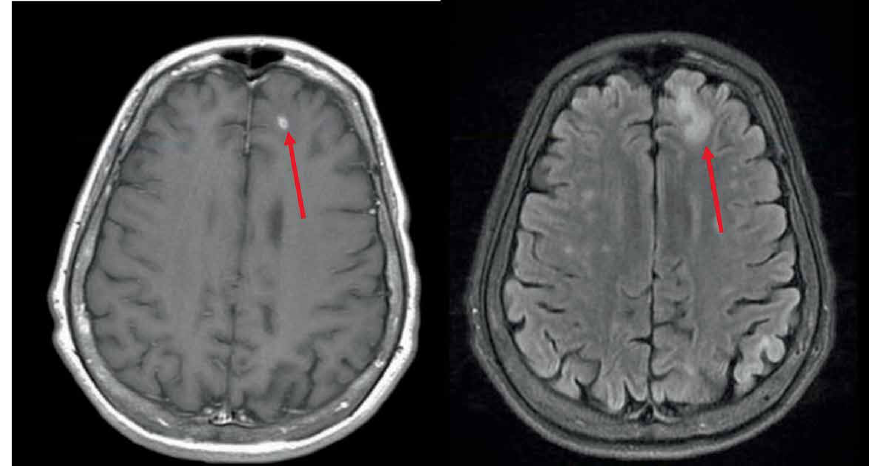
Figure 2: Axial T1 with contrast (left) and axial T2 FLAIR (right) magnetic resonance imaging (MRIs) demonstrating a peripherally enhancing 5 mm lesion in the left frontal lobe surrounded by moderate confluent vasogenic edema, marked by red